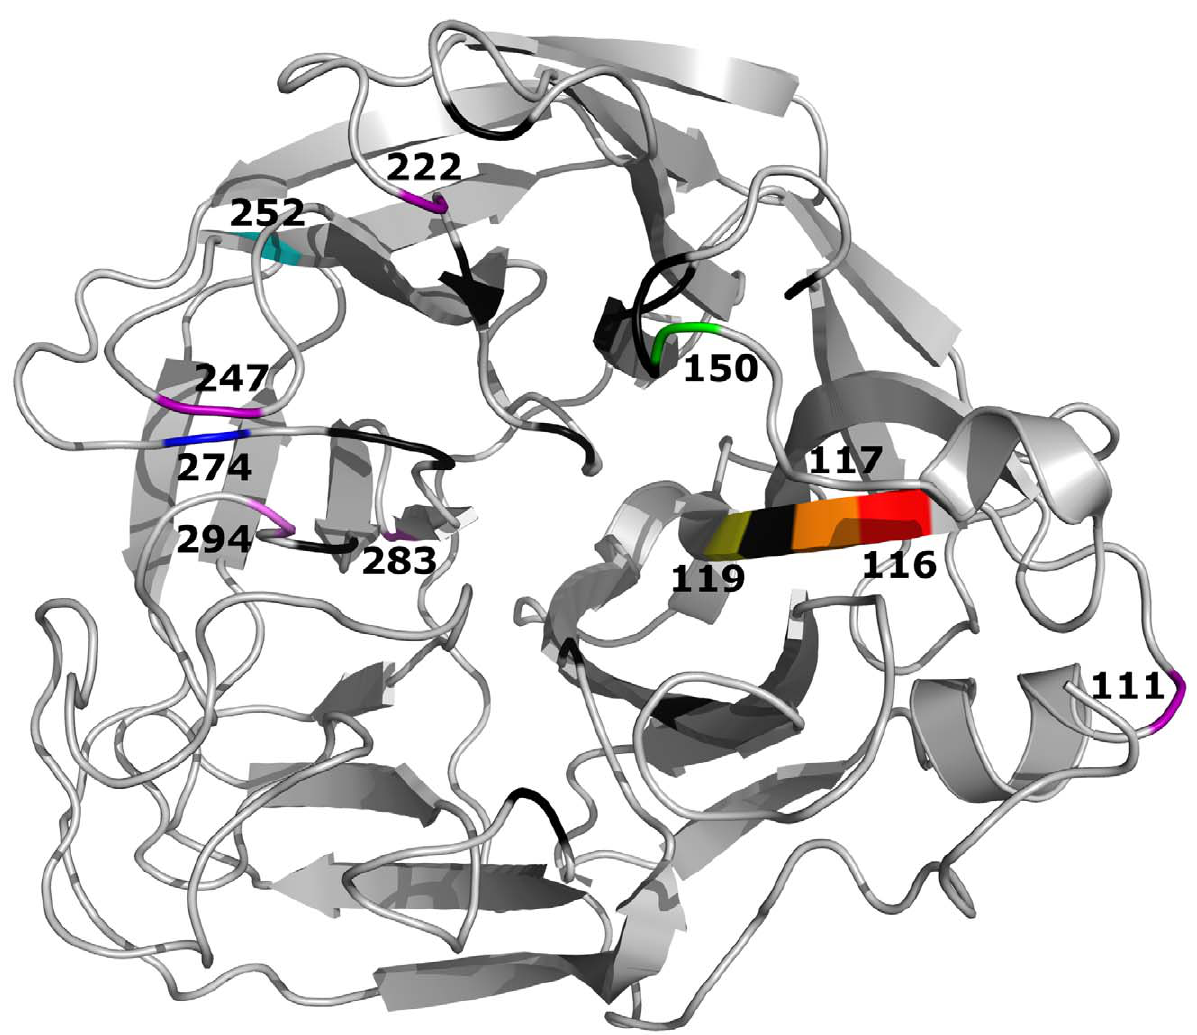
Figure 1. Crystal structure of the A/Vietnam/1203/04 (H5N1) NA molecule (Protein Data Bank:2HTY). Shown are 11 residues in or near the enzyme’s active site (black) that were substituted in this study. Residues shown in purple are positions where a single amino acid substitution affects the stability of the recombinant A/Turkey/15/06-like (H5N1) influenza virus.